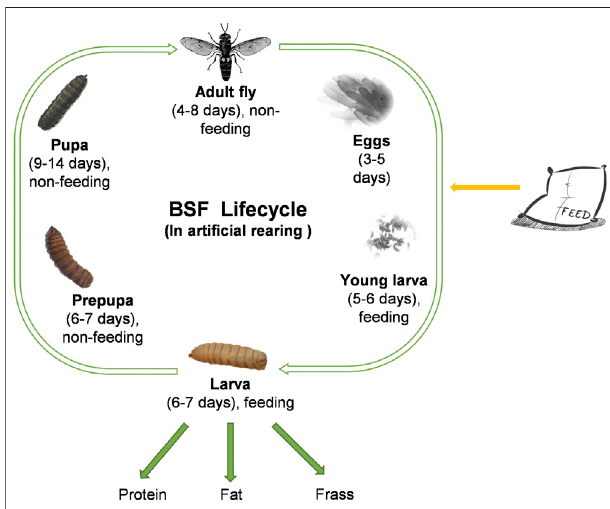
FIGURE 1 | Life cycle of Hermetia illucens